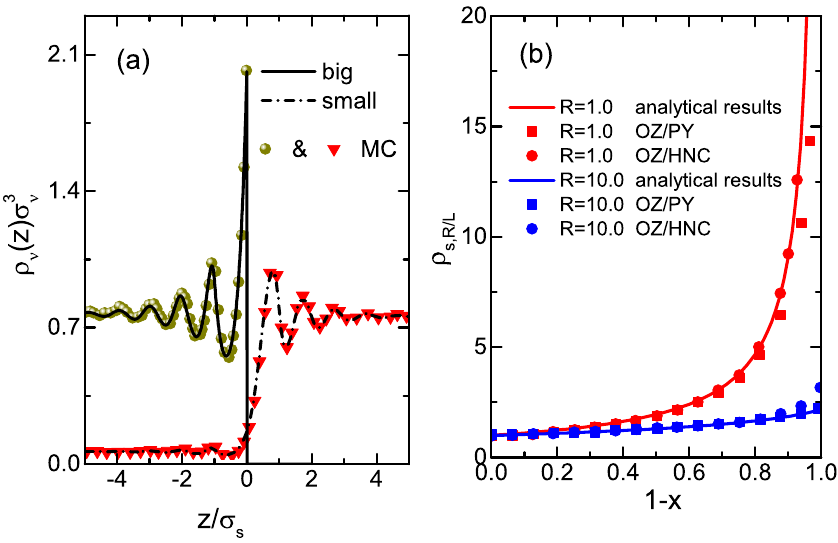
Figure 1. ( a ) Comparison of our density functional results for binary mixture with those from the MC simulation carried out by Bryk et al. [15]. ( b ) Comparison of our analytical results for ρ s , R / L with those from the Ornstein-Zernike integral equation calculation which is carried out by Zhou et al. [9]. π Note that the analytical calculation is performed with η tot = 2 15